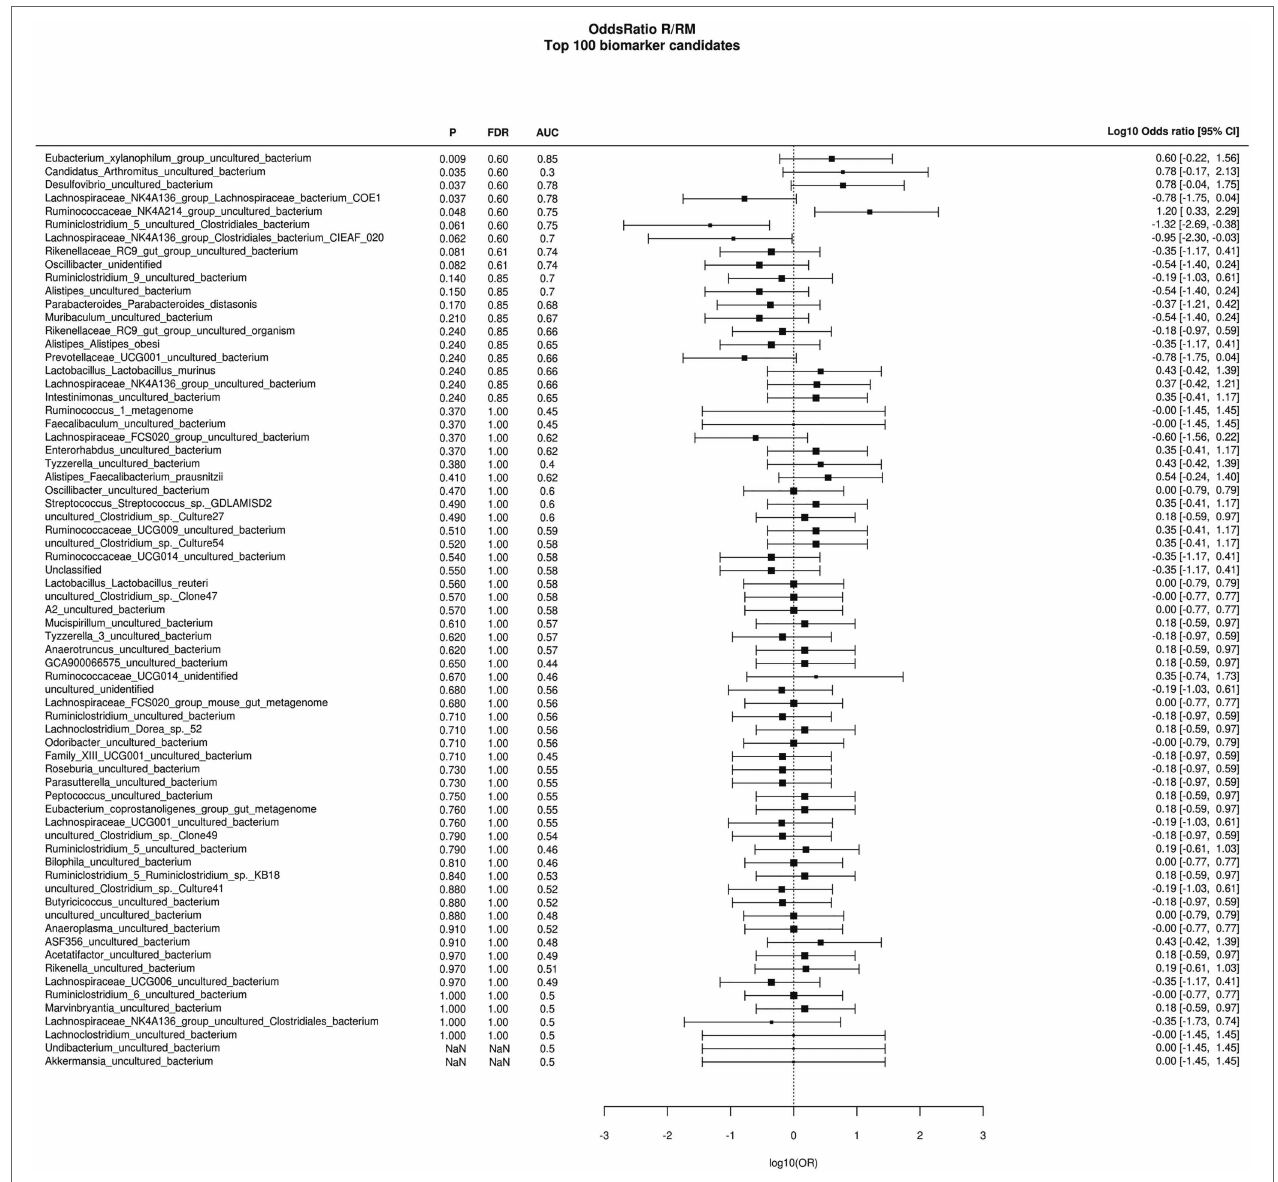
FIGURE 4 | Odds ratio biomarker analysis of the two groups. R, reuterin supernatant (reuterin group); RM, biotransformation medium (reuterin medium group).